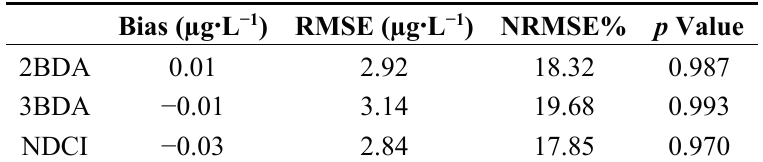
Table 5. Summary results for validation process using in situ hyperspectral data with chl- a values below 20 µg·L − 1 .